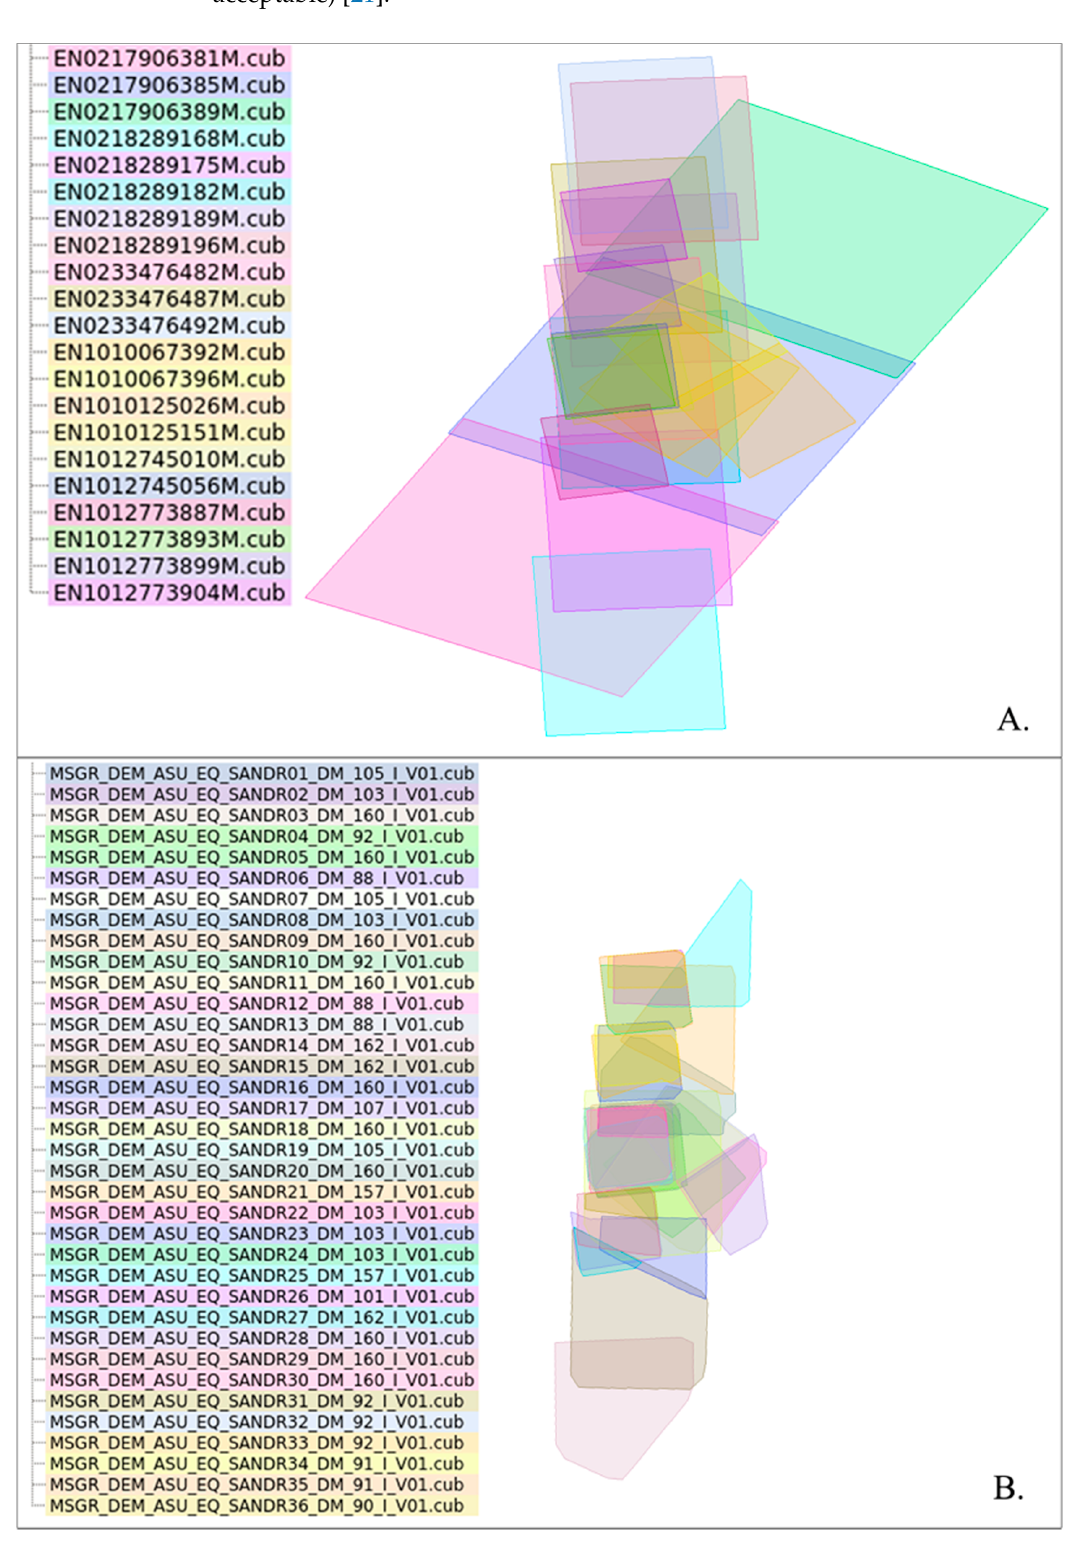
Figure 3. Stereo pairs used to create the Sander crater DEM mosaic: ( A ) shows the footprints of the 21 images chosen, while ( B ) shows the footprints of the 36 individual DEMs made from those images.